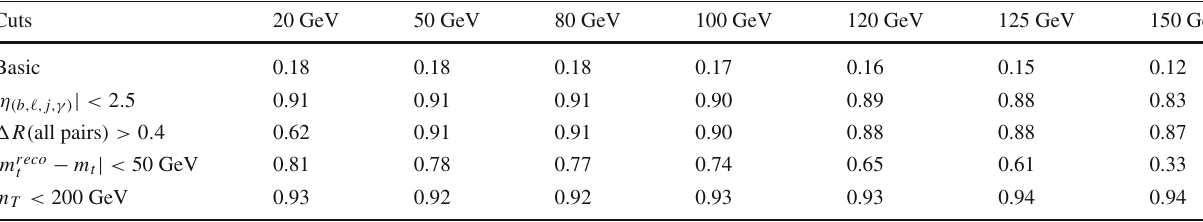
Table 6 Efficiency after each cut for the four dominant backgrounds. SL (LL) denotes semi (di)-leptonic